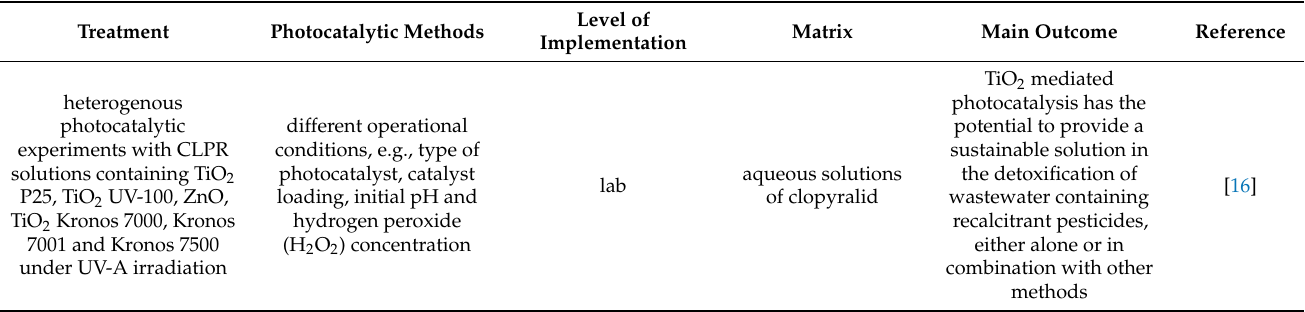
Table 1. Previously published clopyralid studies of our research group, at a